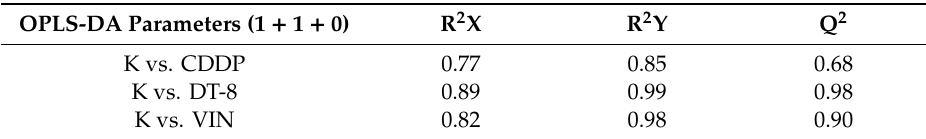
Table 1. Statistical parameters of OPLS-DA models for the classification of 1 H-NMR experiments according to K (controls) and treated (CDDP, DT-8 and VIN). R 2 is described by R 2 X and R 2 Y, which represent the fraction of variance of the X and Y matrix, respectively, Q 2 = predictive